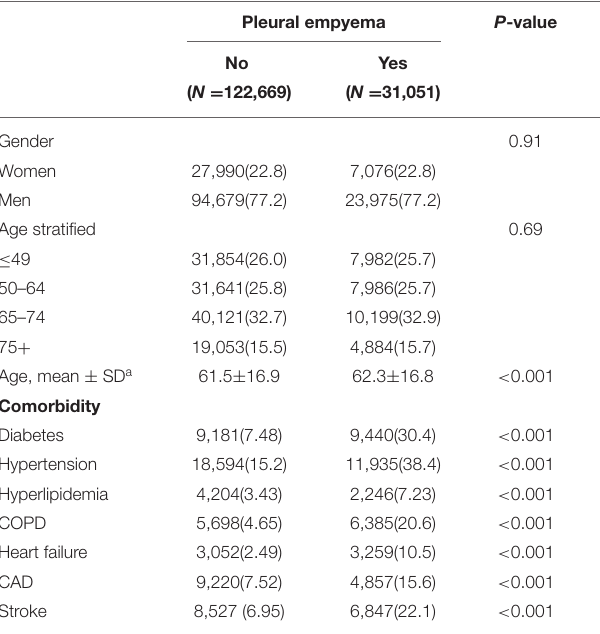
male patients (77.2%), and 48.6% of the patients were of age more than 65 years (mean age 62.3 ± 16.8 years in the PE cohort and 61.5 ± 16.9 years in the non-PE cohort). Patients in the PE cohort exhibited a higher prevalence of comorbidities than those in the non-PE cohort (all P < 0.001). The average follow-up period was 3.49 years for the subjects with PE and 5.40